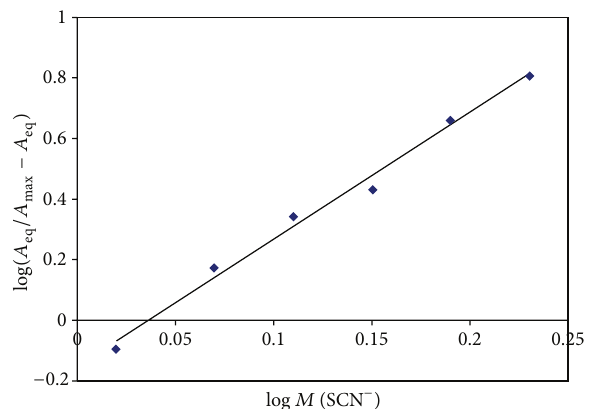
Figure 3: Curve-fitting method for the determination of mole ratio of the Fe(III) to SCN − in the Fe(III)-SCN − -[AMIYTP] + complex.